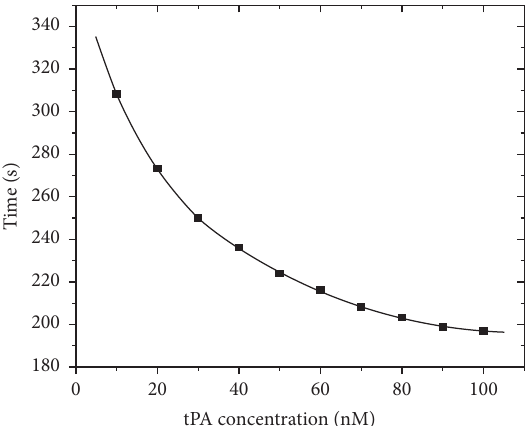
Figure 5: Lysis time over tPA concentration.